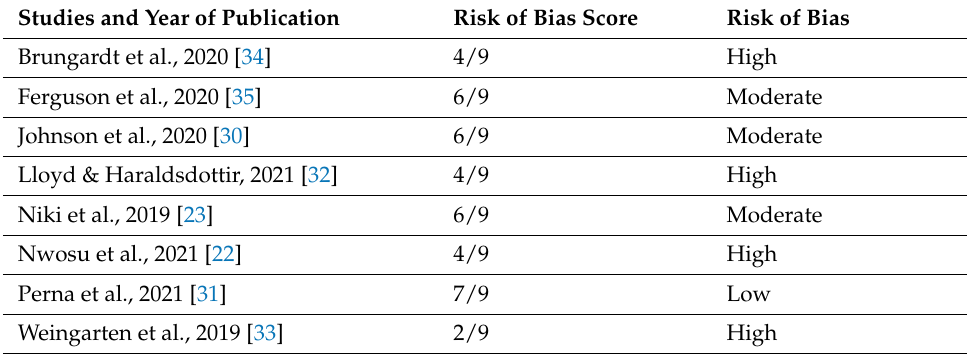
Table 3. Risk of bias